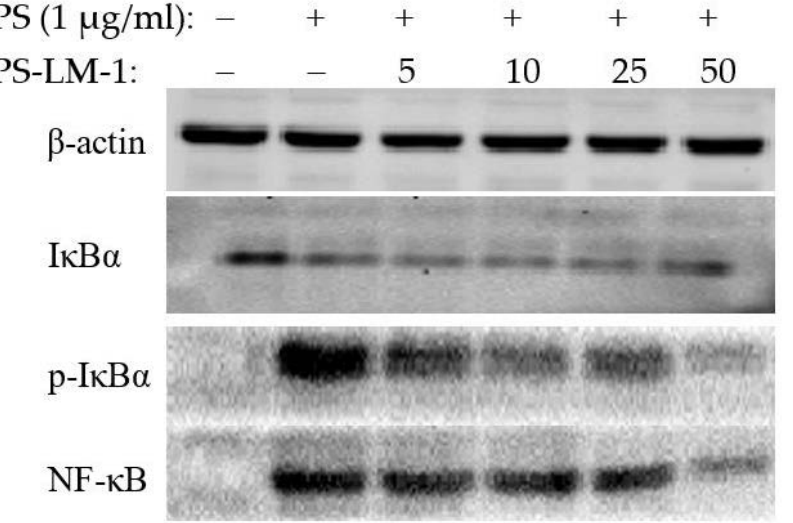
Figure 4. Effects of EPS-LM-1 on the activation of the NF- κ B signaling pathway in LPS-stimulated THP-1 cells ( β -actin: internal reference).